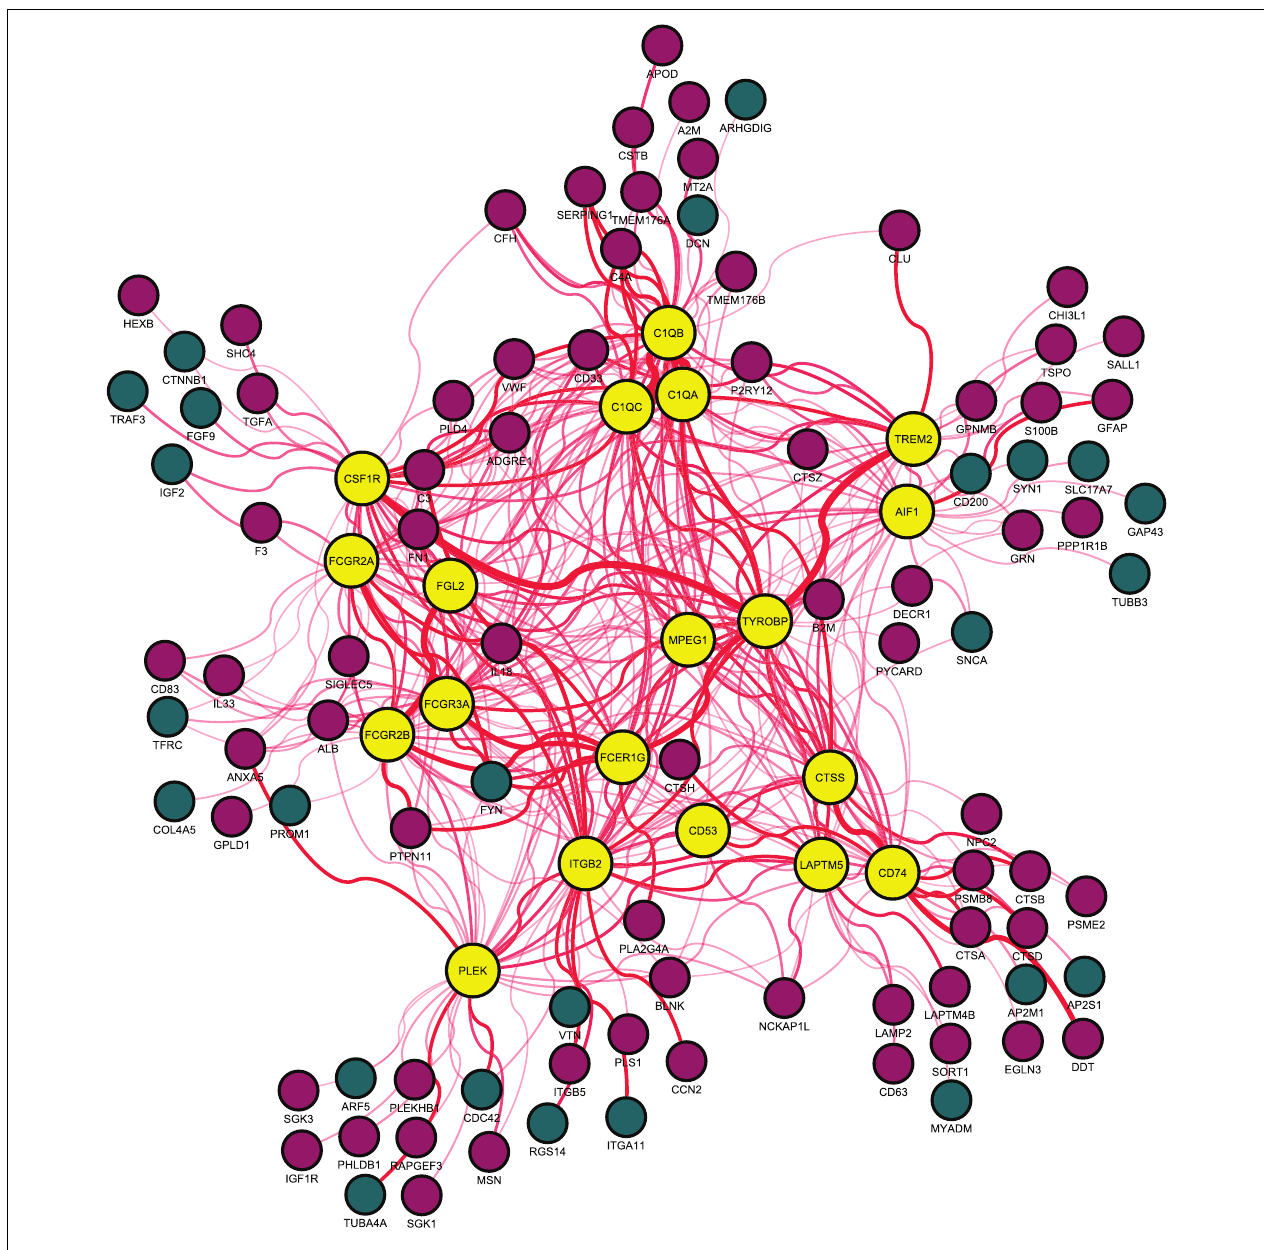
FIGURE 2 | Highest-ranked clustering gene module in the protein-protein interaction network of differentially expressed genes between young (5–8 months) and aged (21–26 months) of the rat hippocampus. Red indicates upregulated and blue downregulated node genes. AIF1, allograft inflammatory factor 1; C1QA, complement C1q A chain; C1QB, complement C1q B chain; C1QC, complement C1q C chain; CD53, CD53 molecule; CD74, CD74 molecule; CSF1R, colony stimulating factor 1 receptor; CTSS, cathepsin S; FCER1G, Fc epsilon receptor Ig; FCGR2A, Fc gamma receptor IIa; FCGR2B, Fc gamma receptor IIb; FCGR3A, Fc gamma receptor IIIa; FGL2, fibrinogen like 2; ITGB2, integrin subunit beta 2; LAPTM5, lysosomal protein transmembrane 5; MPEG1, macrophage expressed 1; PLEK, pleckstrin; TREM2, triggering receptor expressed on myeloid cells 2; and TYROBP, transmembrane immune signaling adaptor